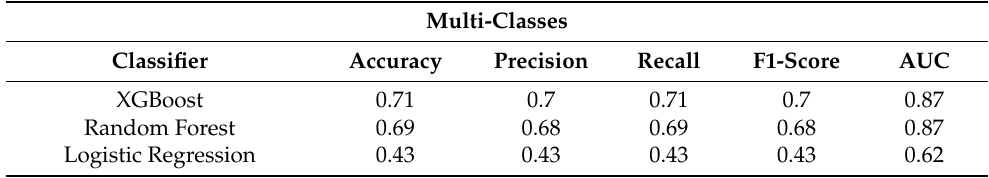
Table 3. Models’ multi-class